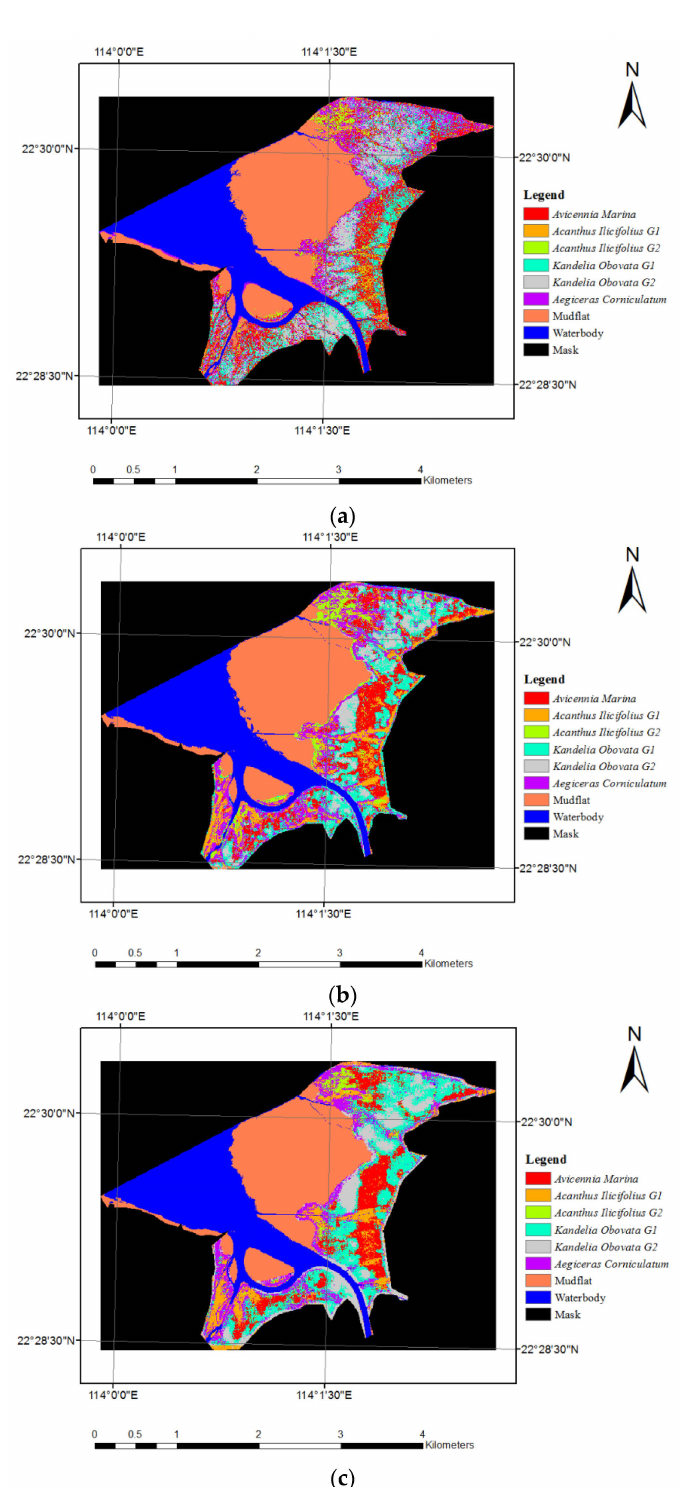
Figure 5. Classification results of Support Vector Machine (SVM) using different features. ( a ) SVM + Original Spectra (OS); ( b ) SVM + Original Spectra and calculated Textures (OST); ( c ) SVM + Original Spectra, calculated Textures and Differential spectral features